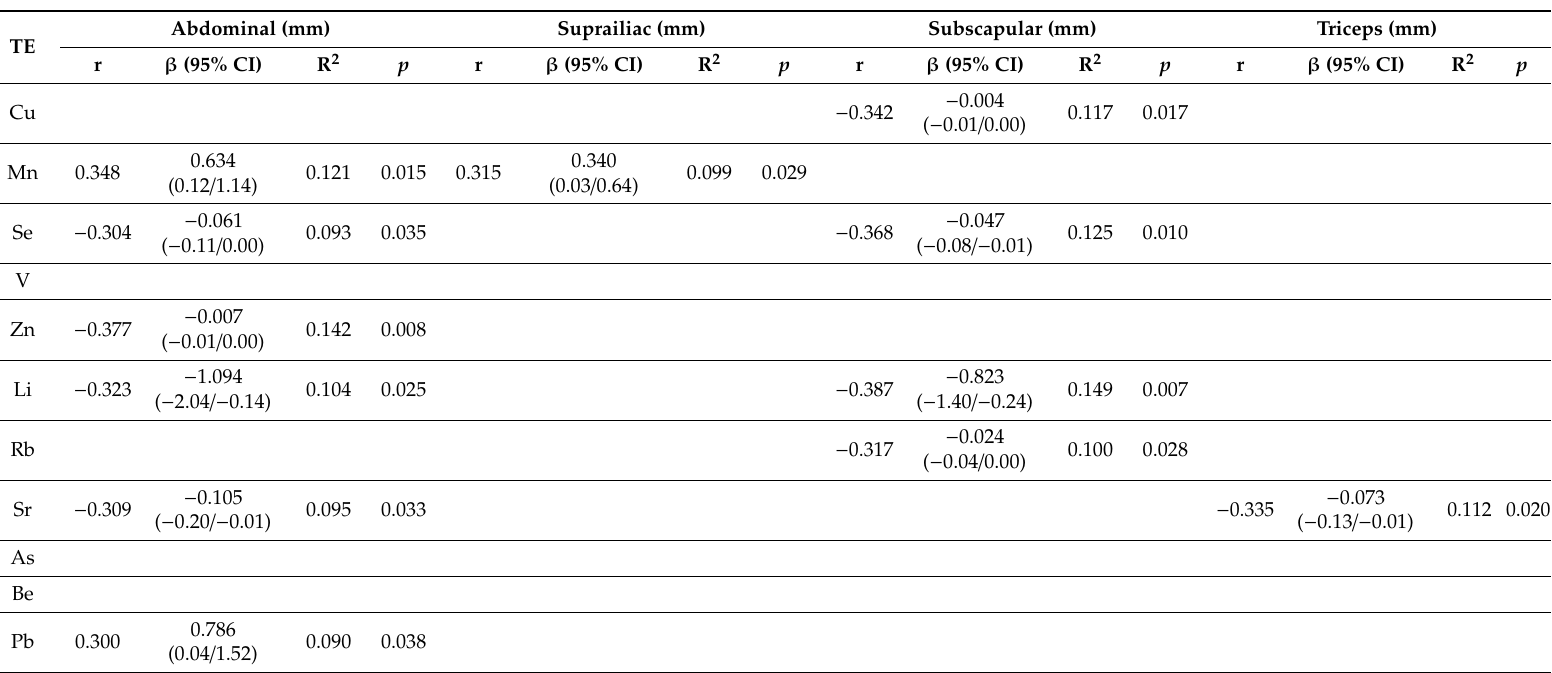
Table 4. Correlations between abdominal, suprailiac, subscapular and triceps skinfolds with trace elements in the